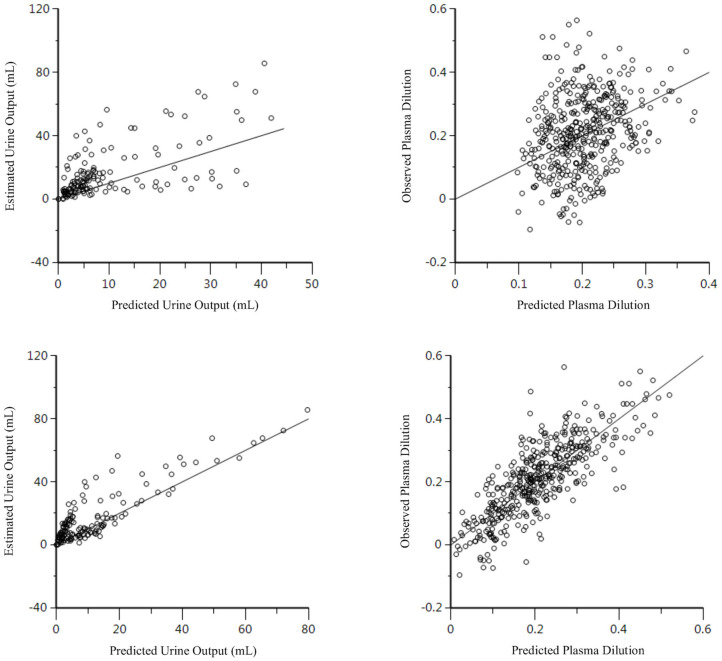
Residual plots for the 2-VOFS kinetic model of group fluid analysis before (top) and after (bottom) considering the covariate effects of fluid types and MAP.